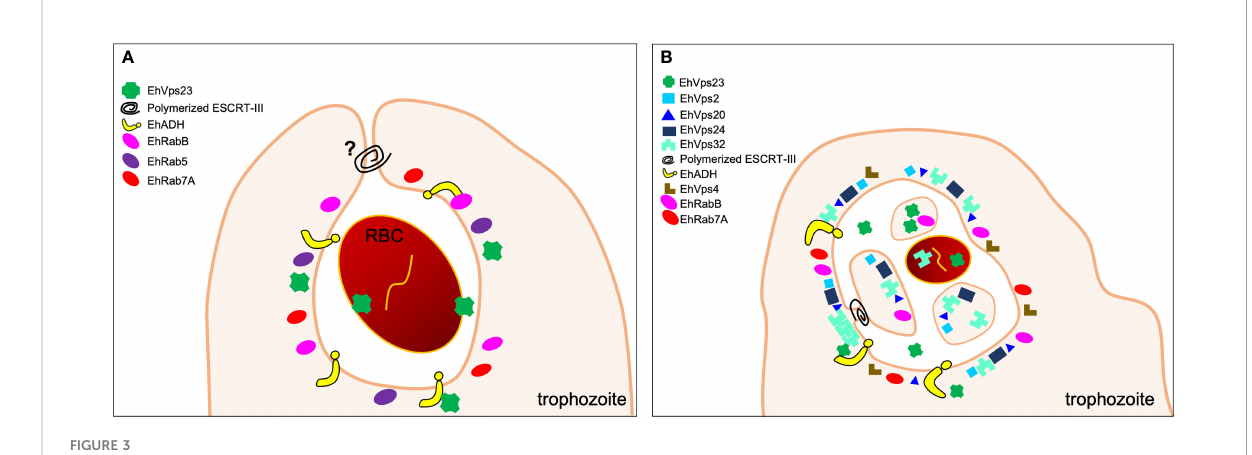
FIGURE 3 EE and LE/MVBs maturation. (A) Once the phagocytic cup detaches from the PM, the phagosomes are formed. For the scission of the nascent vesicles, possibly the polymerized ESCRT-III participates. In EE, several EhRabs and ESCRT-I and ESCRT accessory proteins are localized. (B) During the EE transition to LE/MVBs, the ESCRT-III and ESCRT accessory proteins contribute in the ILVs generation. In addition, some EhRabs are localized at LE, suggesting their participation in LE